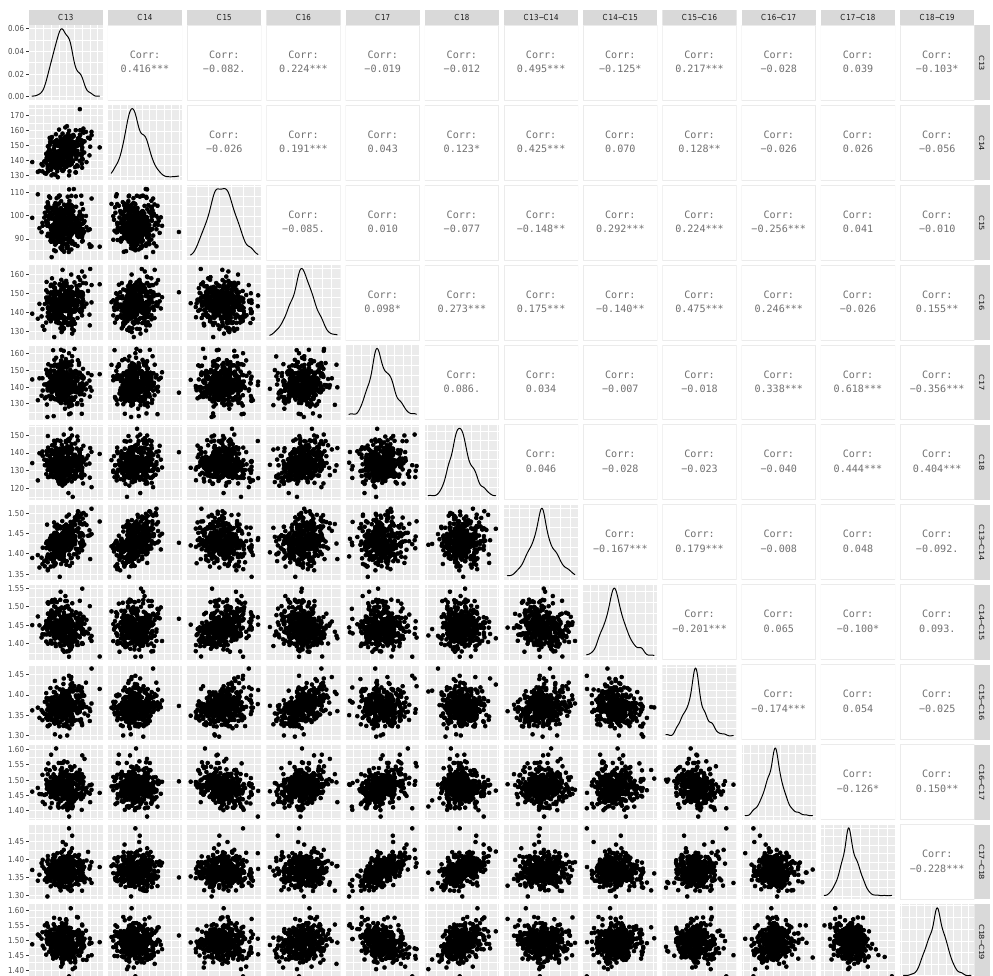
Figure A1. Normalised RMSE of calculated shieldings with increasing size of the QM part ( left ) and after subsequent annealing and equilibration of FFMD snapshots ( right ) at the example of AnPixJg2. Appendix A.2. Statistical Data Figure A2 shows the explicit correlation plot of all features and outcomes of this analysis. It corresponds to the correlation matrix shown in Figure 3.